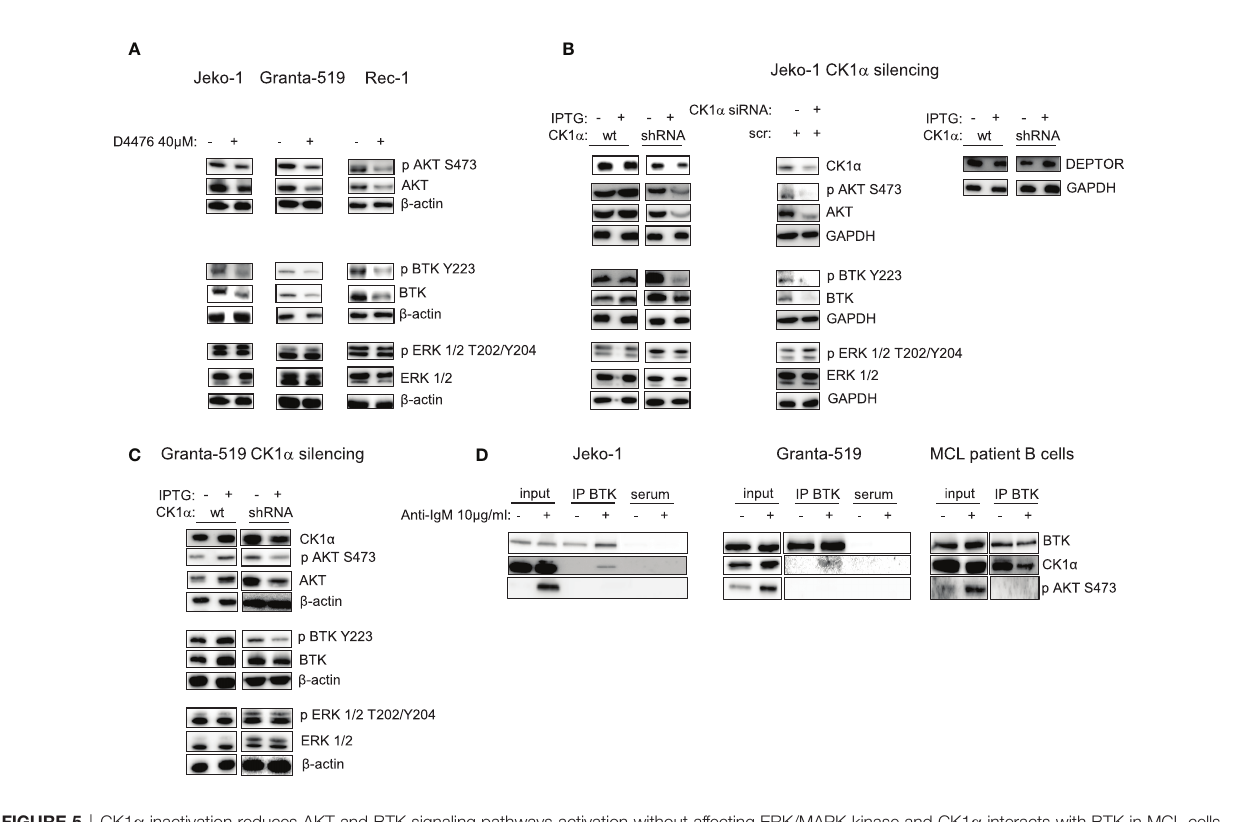
FIGURE 5 | CK1 a inactivation reduces AKT and BTK signaling pathways activation without affecting ERK/MAPK kinase and CK1 a interacts with BTK in MCL cells. Representative WB of AKT, BTK and ERK1/2 dependent signaling in MCL cell lines Jeko-1 Granta-519 and Rec-1 treated with D4476 40uM for 48h (A) or in Jeko-1 IPTG inducible CSNK1A1 directed shRNA clone (named CK1 a shRNA) and in Jeko-1 wt treated with IPTG 500µM for 13 days ( B left and right panel) or Jeko -1 cells electroporated with CSNK1A1 directed siRNAs ( B middle panel), or in Granta-519 IPTG inducible CSNK1A1 directed shRNA clone (named CK1 a shRNA) treated with IPTG 500µM for 72h (C) . Membranes for WB analysis were probed with antibodies listed in the fi gure. GAPDH or b actin was used as loading control. Experiments were repeated at least three times. (D) Immunoprecipitation (IP) of BTK in Jeko-1 (left panel), Granta-519 (middle panel), or puri fi ed B lymphocytes from one MCL patient (pt#2) (right panel), stimulated with anti-IgM 10µg/ml for 5 min. WB was probed with anti-CK1 a and anti-BTK antibodies. To ensure BCR activation AKT phosphorylation on S473 (pAKT S473) was detected after anti-IgM stimulation in the total cell lysate